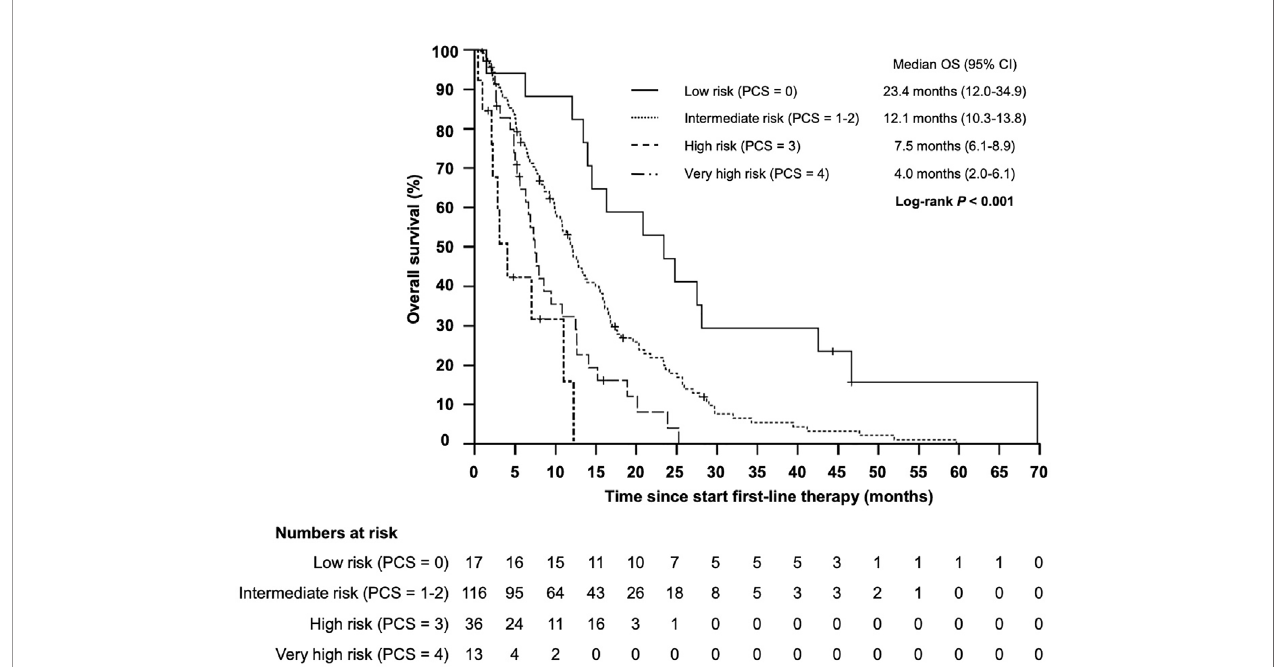
FIGURE 4 | Kaplan – Meier plot for overall survival (OS) according to the prognostic clinical score (PCS) from start of fi rst-line therapy for low (PCS = 0 points), intermediate (PCS = 1 – 2 points), high (PCS = 3 points), and very high risk (PCS = 4 points) groups ( P < 0.001).